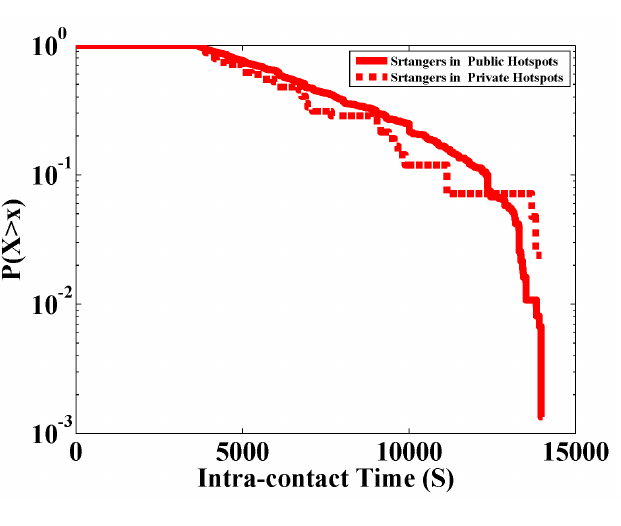
Figure 6. Intra-contact time CCDF for